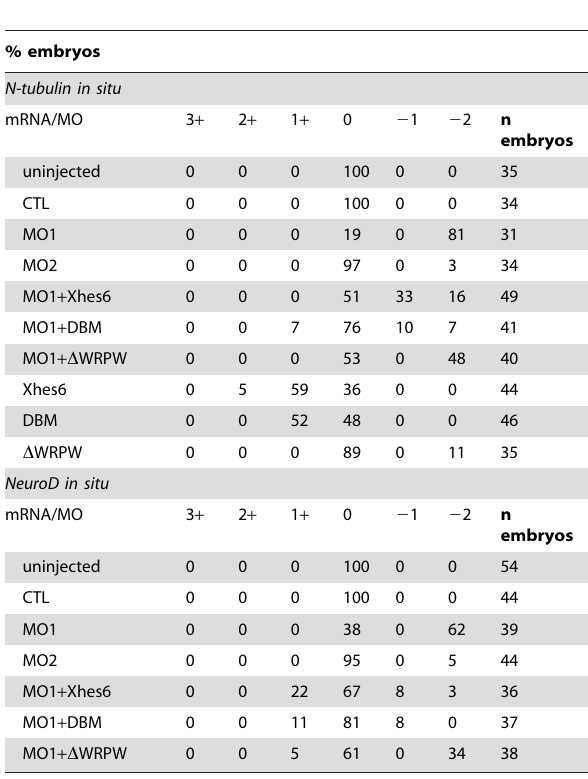
Table 1. Effect of Xhes6 morpholinos on neural marker